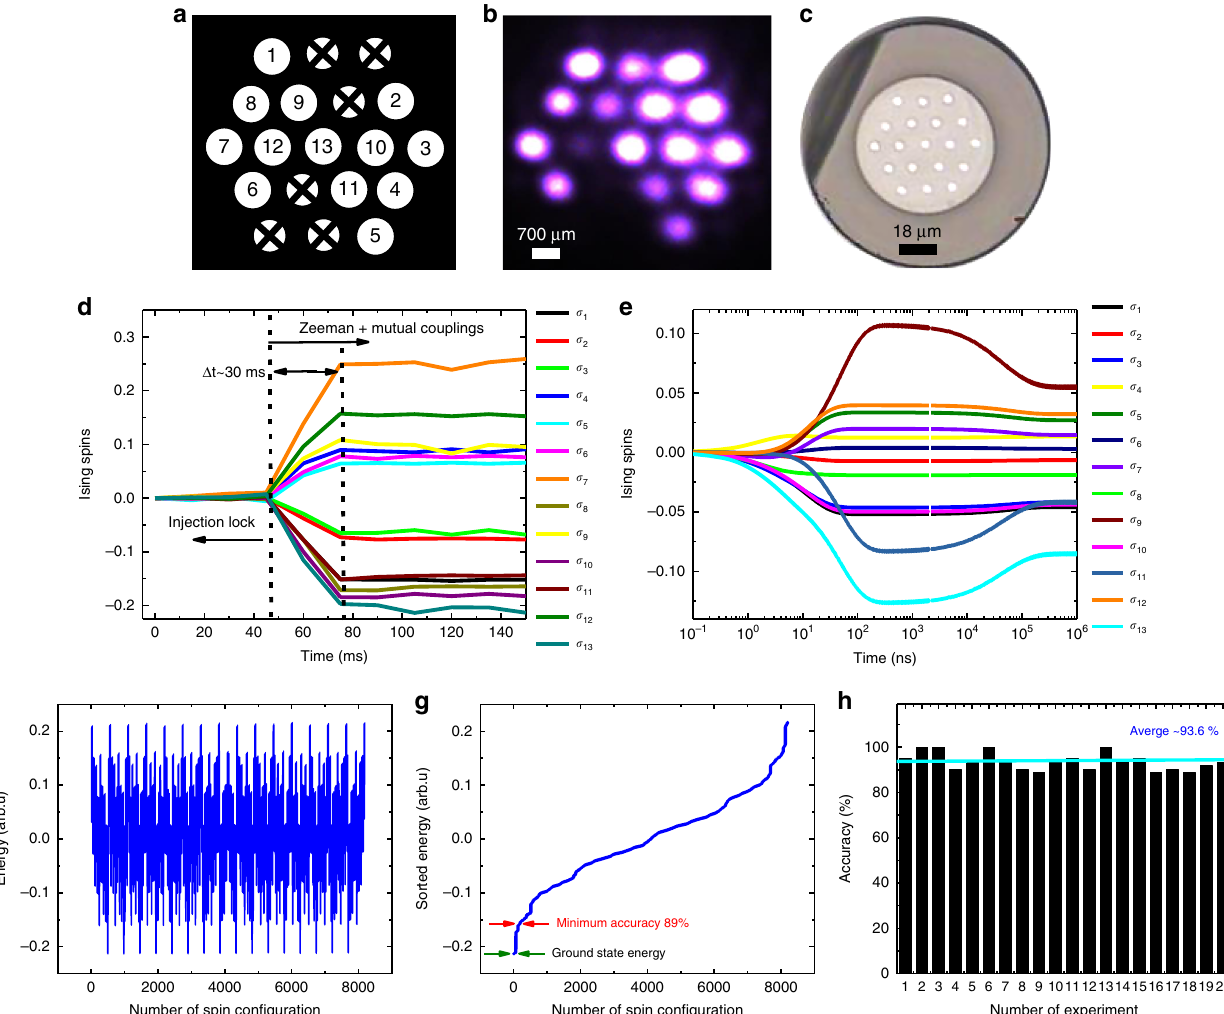
Fig. 6 Central symmetry couplings results. a A scheme of MCF for N = 13 and node connections in an image inversion transformation. The connections are between SL 1 – 5, 2 – 6, 3 – 7, 4 – 8, 9 – 11, and 10 – 12. b An image of the MCF ’ s facet with 16 SLs that have the most stable and uniform power for the experiment while three of SLs cannot be used for the Ising Hamiltonian because of the inverse imaging cross-couplings. This makes the Ising Hamiltonian with size of N = 13. c A microscope picture from the facet of the Ytterbium doped phosphate glass MCF. d The calculated Ising spins evolution based on the measured relative intensities between photon numbers in right and left circular polarizations, detected by a CMOS CCD camera. e Simulated Ising spins based on the experimental data that we fed to the Ising solver code and excellent agreement with d in terms of spin signs. Both experiment and MCF simulation found the ground state spin con fi guration for the Ising Hamiltonian. f Computed Ising energy values for all possible spin con fi gurations (2 13 ) using a brute-force algorithm (BFA). g Sorted Ising energy values from f versus number of spin con fi gurations. h Average accuracy of the optical coherent Ising machine (CIM) for that particular Ising Hamiltonian with N = 13, was calculated to be 93.6% of actual value of the ground state Ising Hamiltonian. The minimum accuracy that was performed by the experiment was 89%. The CIM relaxed to the exact ground state four times out of 20 times